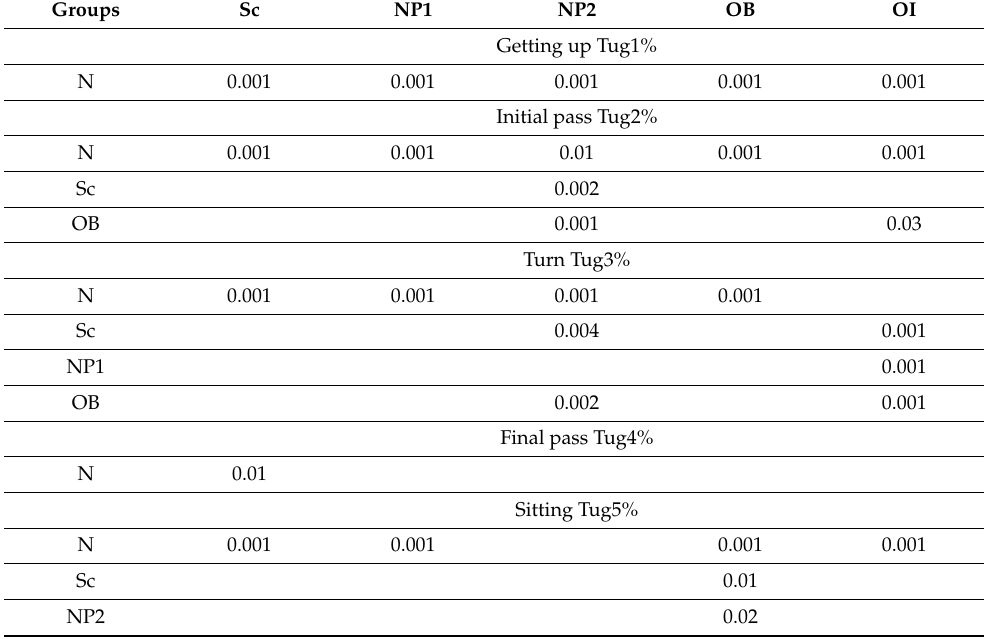
Table 4. The significance of differences in the individual components of the TUG test between the studied